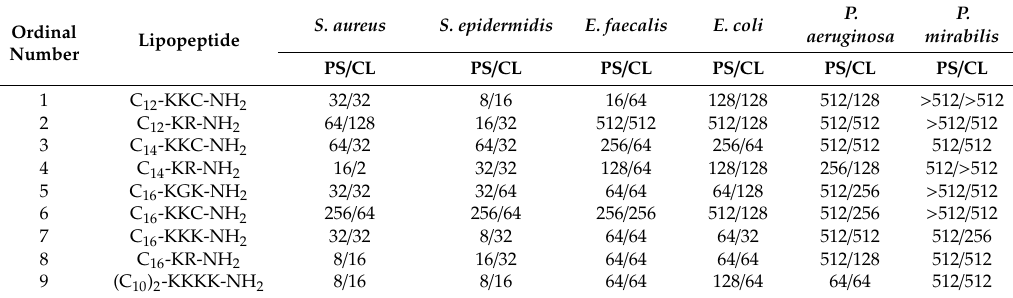
Table 4. Minimum biofilm formation inhibitory concentration (MBFIC) of the lipopeptides ( µ g / mL) for polystyrene plates (PS) and contact lenses